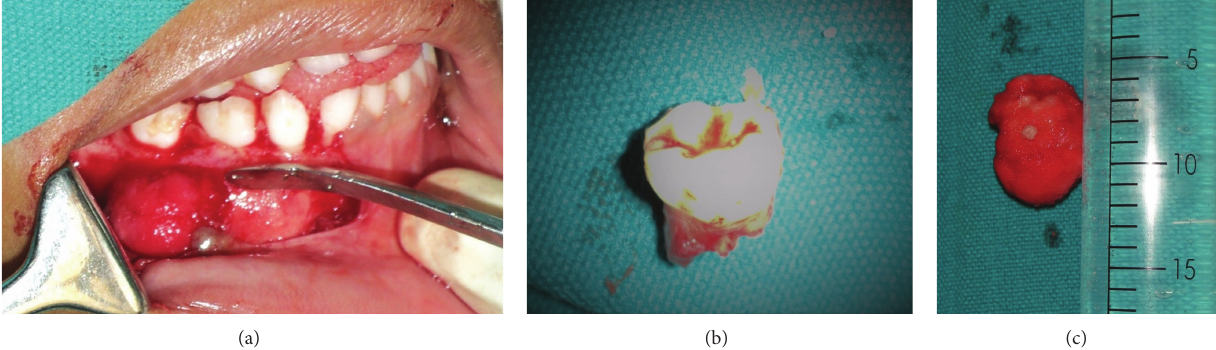
Figure 3: Firm and well demarcated swelling after elevation of mucoperiosteal flap (a), tooth involved (b), and the excised tissue (c).